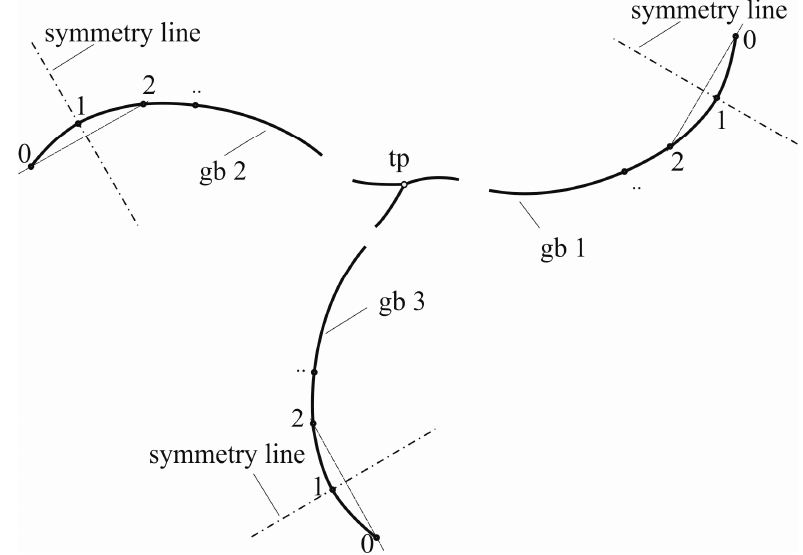
Figure 6. Implementation of the symmetry boundary conditions at the centers of the grain boundaries.